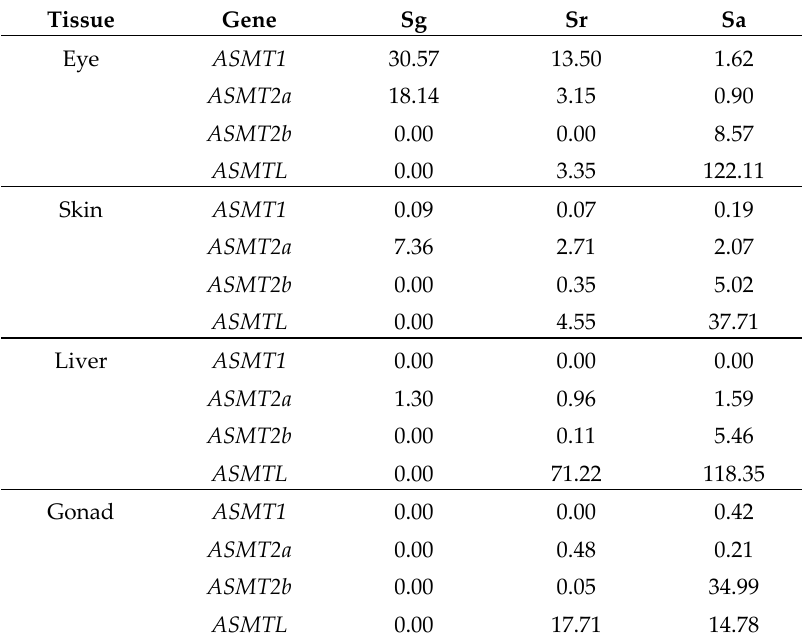
Table 2. Reads Per Kilobase Transcriptome per Million (RPKMs) of ASMT transcripts in three Sinocyclocheilus